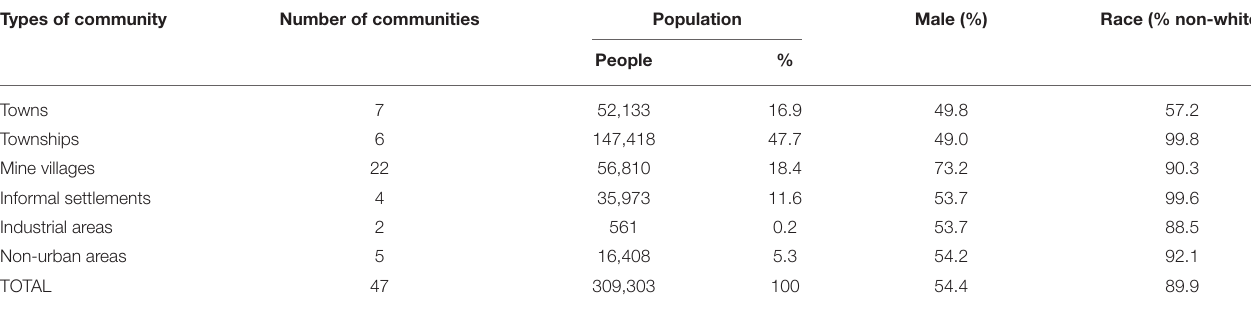
TABLE 3 | Summary of communities (based on census main places) in the Far West Rand in 2011. Types of community Number of communities Population Male (%) Race (% non-white)